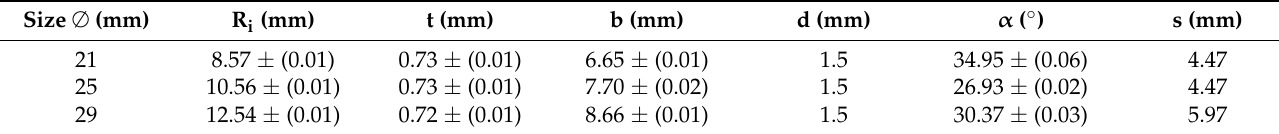
Table A2. Settings values of the experimental set-up and characteristic dimensions of samples produced through the modified deposition process that underwent the three-point bending test. R i , t, b, d; α and s indicate, respectively: the internal radius, the thickness, the width, the roller diameter, the support angle, and the half distance between the supporting rollers.